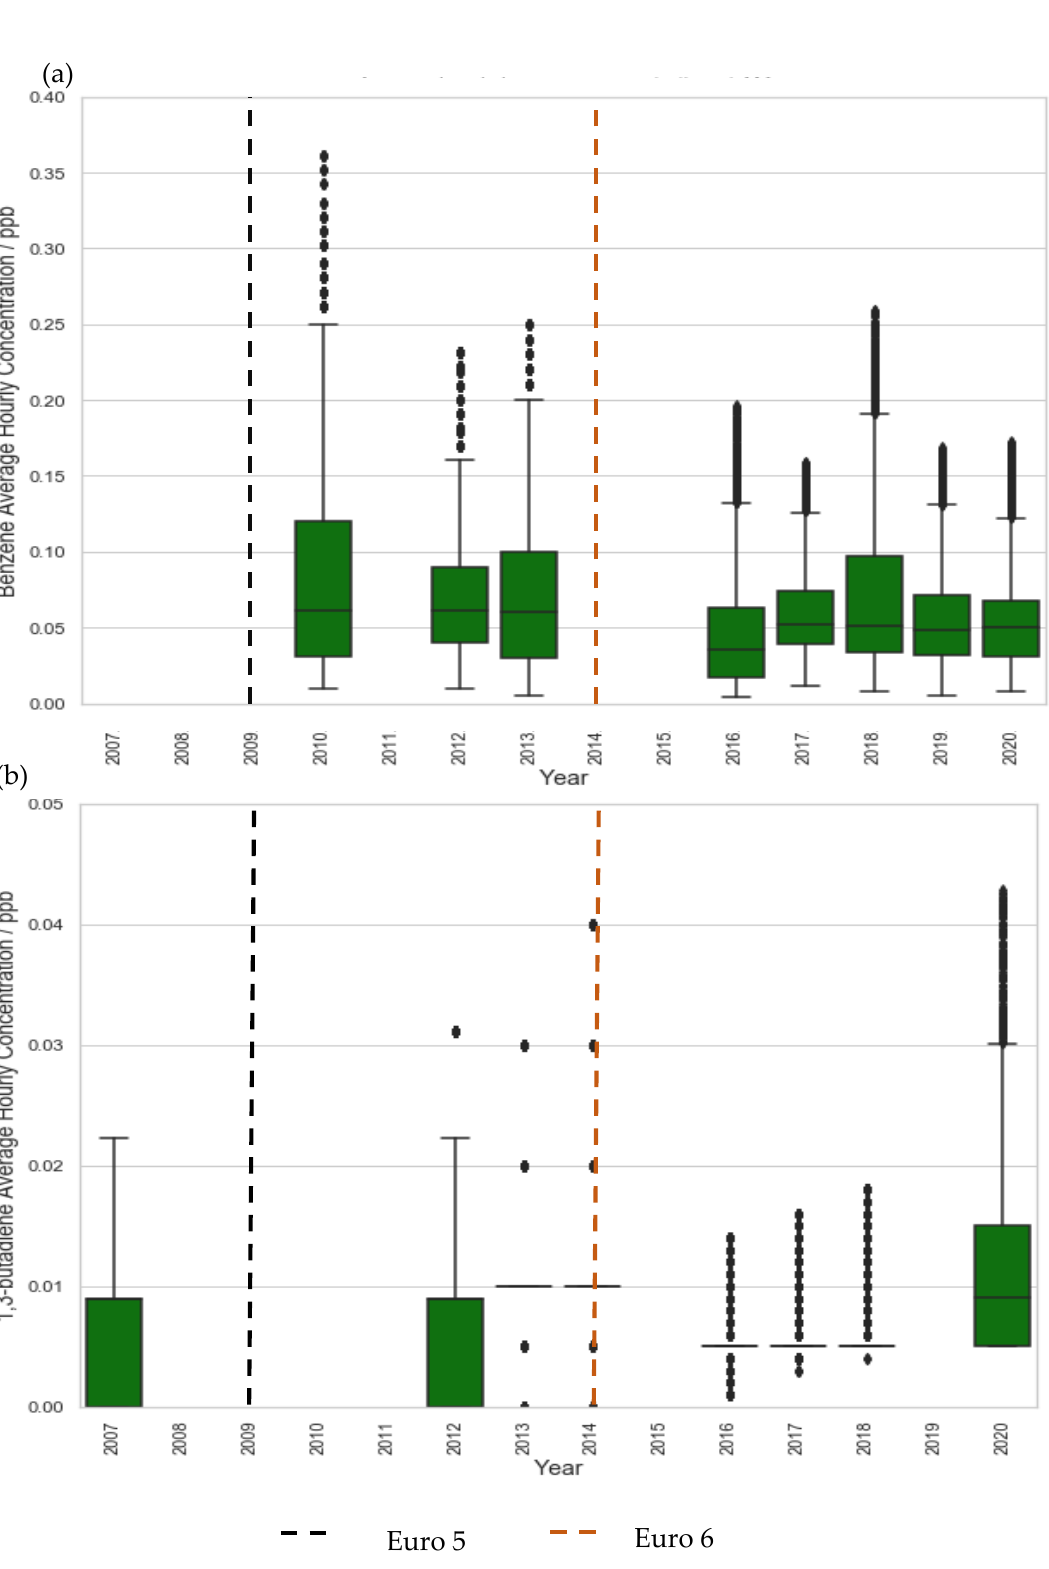
Figure 3. Trends in hourly-average pollutant concentration at the rural site AM over the period 2007–2020 ( a ) benzene and ( b ) 1,3 butadiene. Error bars represent the 95% confidence level in pollutant concentration. Vertical lines represent implementation year of each relevant Euro control. Years with data coverage below 70% were omitted from analysis to avoid seasonal skewing (see Appendix A for data coverage representation).